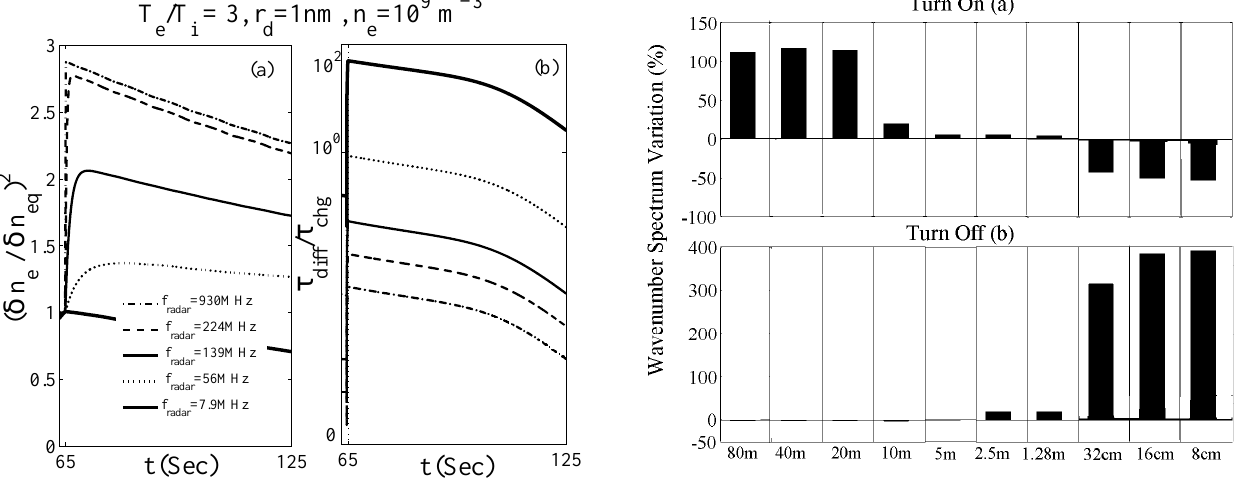
Fig. 6. The wave number spectrum for electron density fluctuation evolution, during and after radio wave heating.